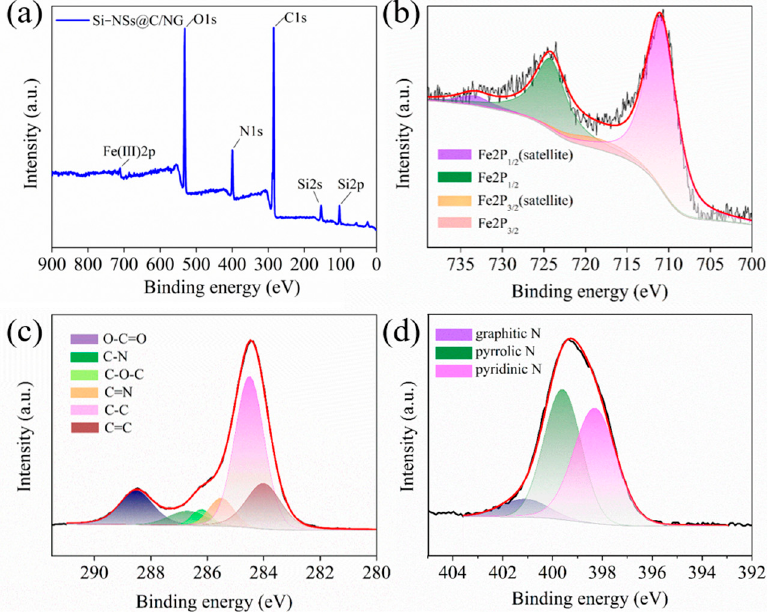
Figure 3. ( a ) XPS survey spectra of Si–NSs@C/NG; spectrum of ( b ) Fe2p; ( c ) C1s; ( d )